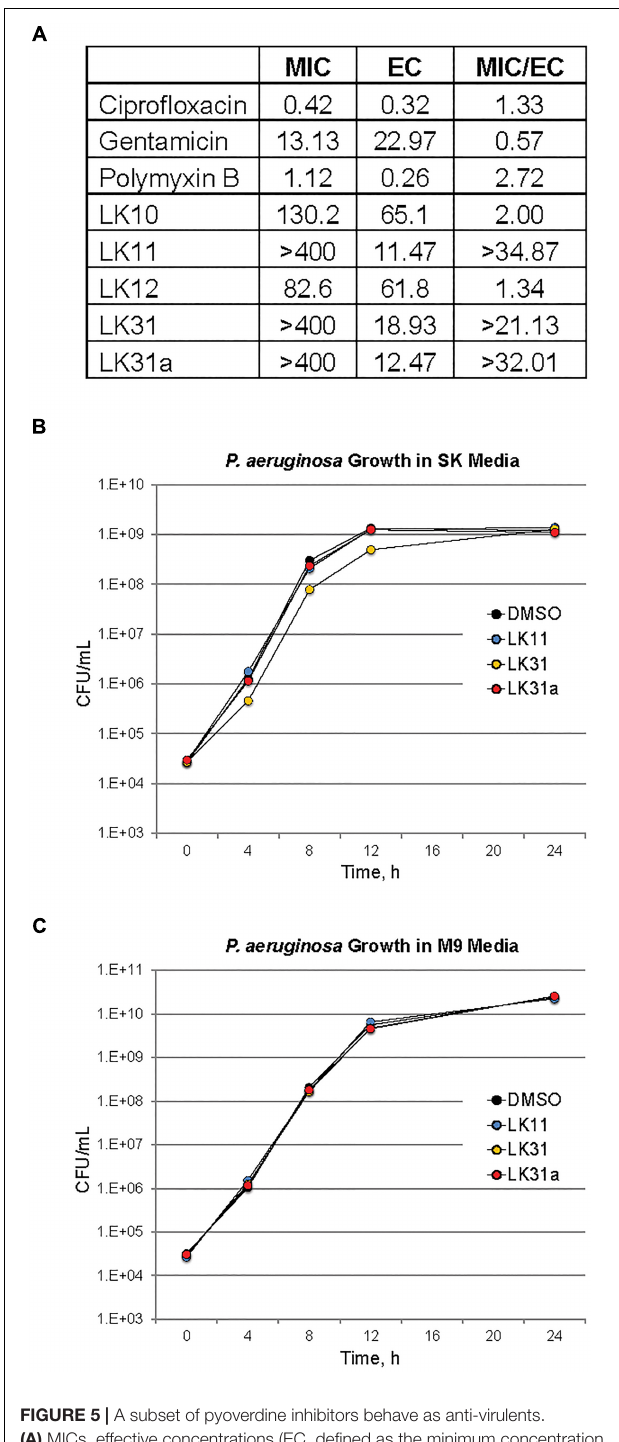
FIGURE 5 | A subset of pyoverdine inhibitors behave as anti-virulents. (A) MICs, effective concentrations (EC, defined as the minimum concentration required for statistically significant amelioration of killing), and the ratios of MIC to EC are shown for a panel of classical antimicrobials, the antivirulents LK11, LK31, and LK31a, and the bifunctional compounds LK10 and LK12. (B,C) Colony-forming unit counts for P. aeruginosa grown in the presence of DMSO or 100 µ M of LK11, LK31, and LK31a in nutrient-poor SK media (B) or more nutritious M9 media (C) . At least three biological replicates were performed for each experiment.